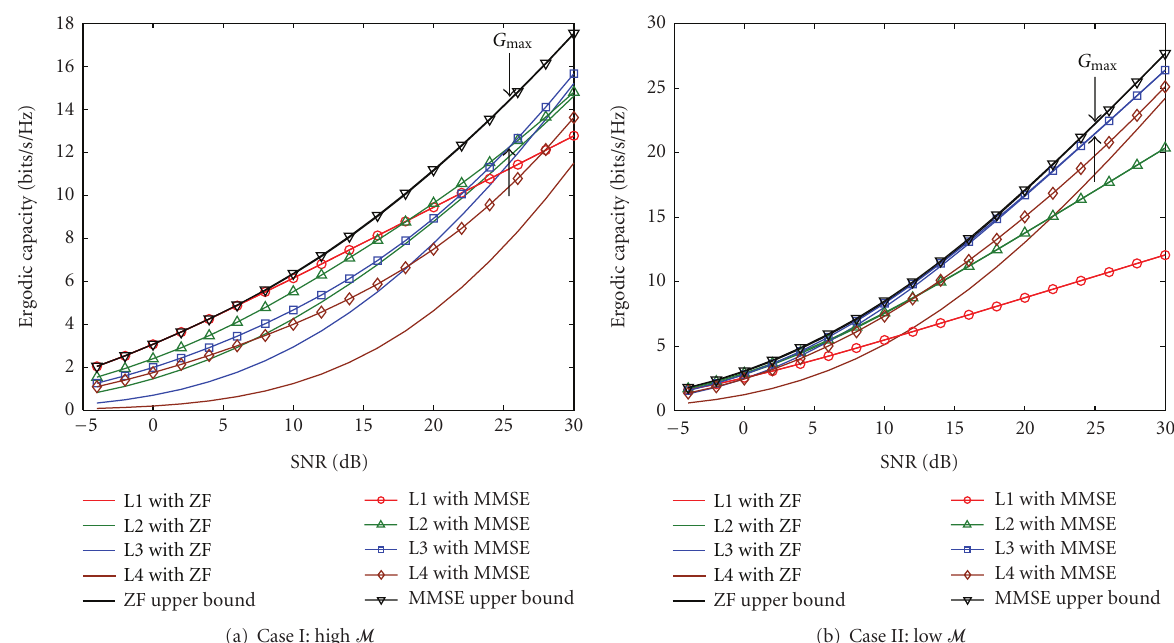
Figure 5: Capacity of di ff erent layer transmissions with ZF and MMSE receivers using CLSM